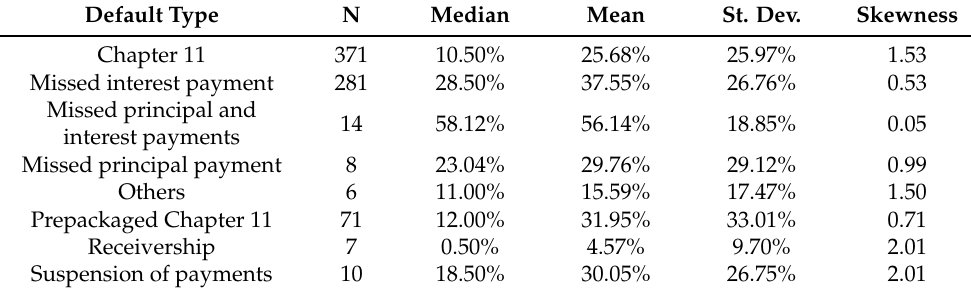
Table 5. Summary statistics of recovery rates according to the default type.